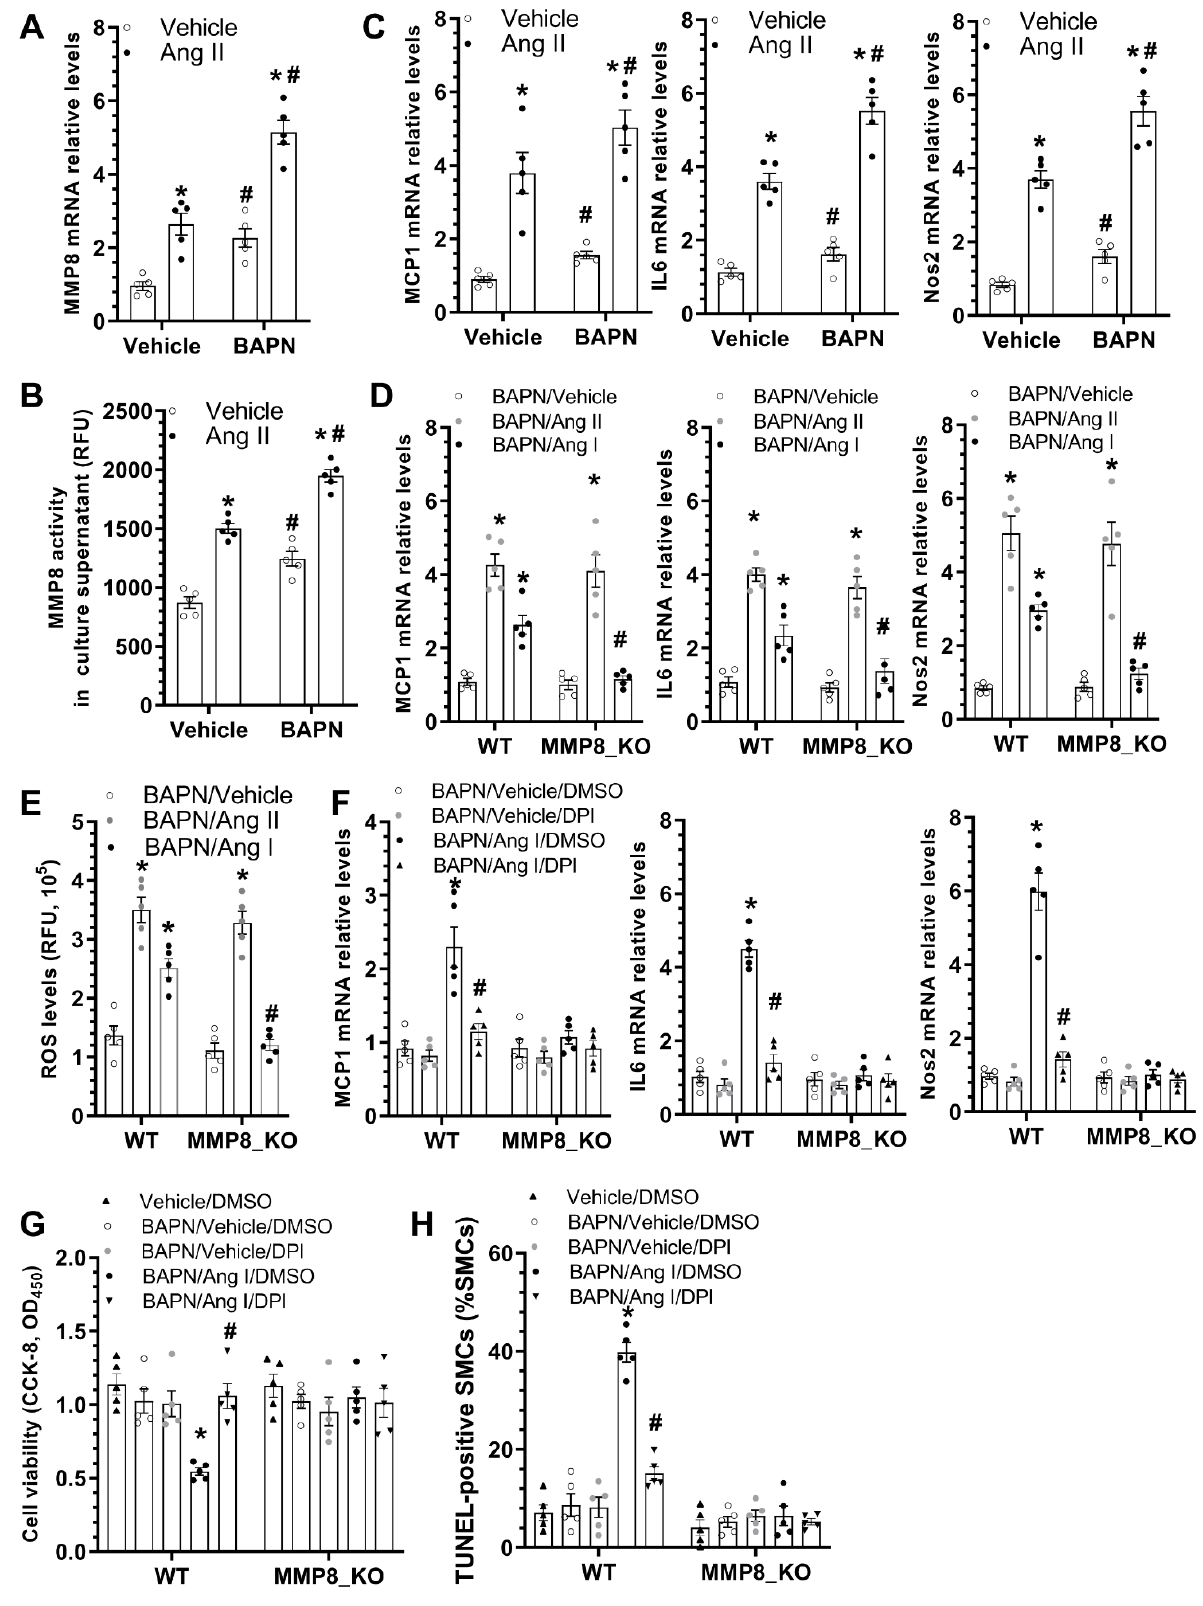
Figure 6. MMP8 increased BAPN/Ang II-induced SMC inflammation and apoptosis via ROS generation. ( A , B ) BAPN and Ang II synergically increased MMP8 gene expression and activity in SMCs. SMCs were treated with 25 μg /mL BAPN with or without 10 nM Ang II for 24 h. Total RNAs and cell culture supernatant were collected and subjected to RT-qPCR analysis ( A ) and MMP8 activity